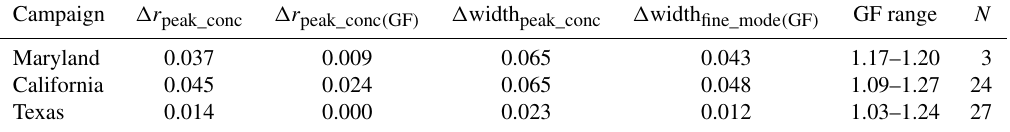
Table 2. For the comparison subset where humidification adjustment of the LARGE data was possible, average differences (in µm) in r peak_conc and width peak_conc between AERONET- and LARGE-derived values are shown for uncorrected and growth-factor-corrected (GF) cases. Also shown are the range of the growth factor applied for each campaign subset and the number of comparisons.